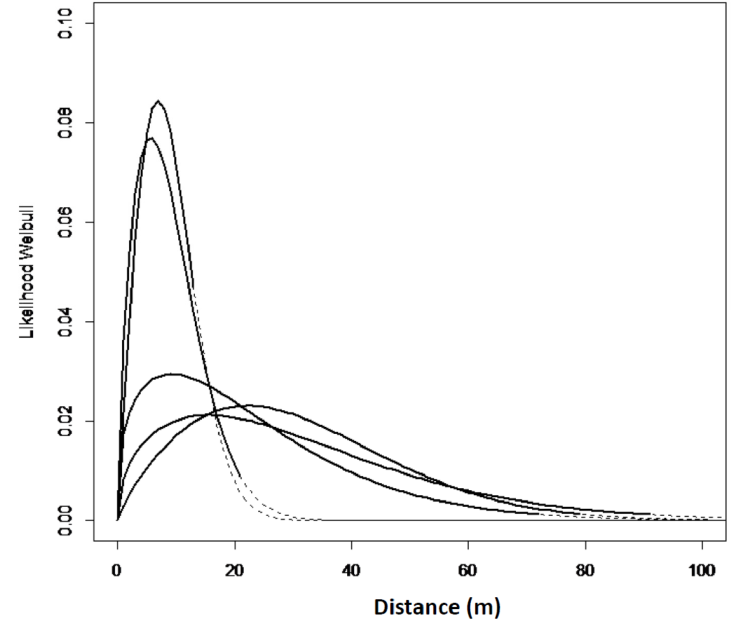
Figure 4. Expected Weibull distribution for five sites in north Norway Model No. 1. The Hatched lines denote extrapolated values, outside max establishment distance. Table 3. Optimalization process and goodness of fit of two empirical models, spread distances for Sitka spruce in coastal Norway. Alpha and Beta are the model coefficients. i denotes a parameter for each plot, k = parameter for north Norway and west Norway. For the models, Log, AIC, and L-ratio are test statistics. Degrees of freedom = Df; AIC = Akaike’s information